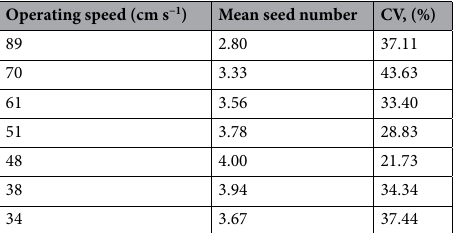
Table 4. The mean number of seeds deposited in each hill by the carrot seeder and the corresponding coefficient of variation as affected by operating speed.